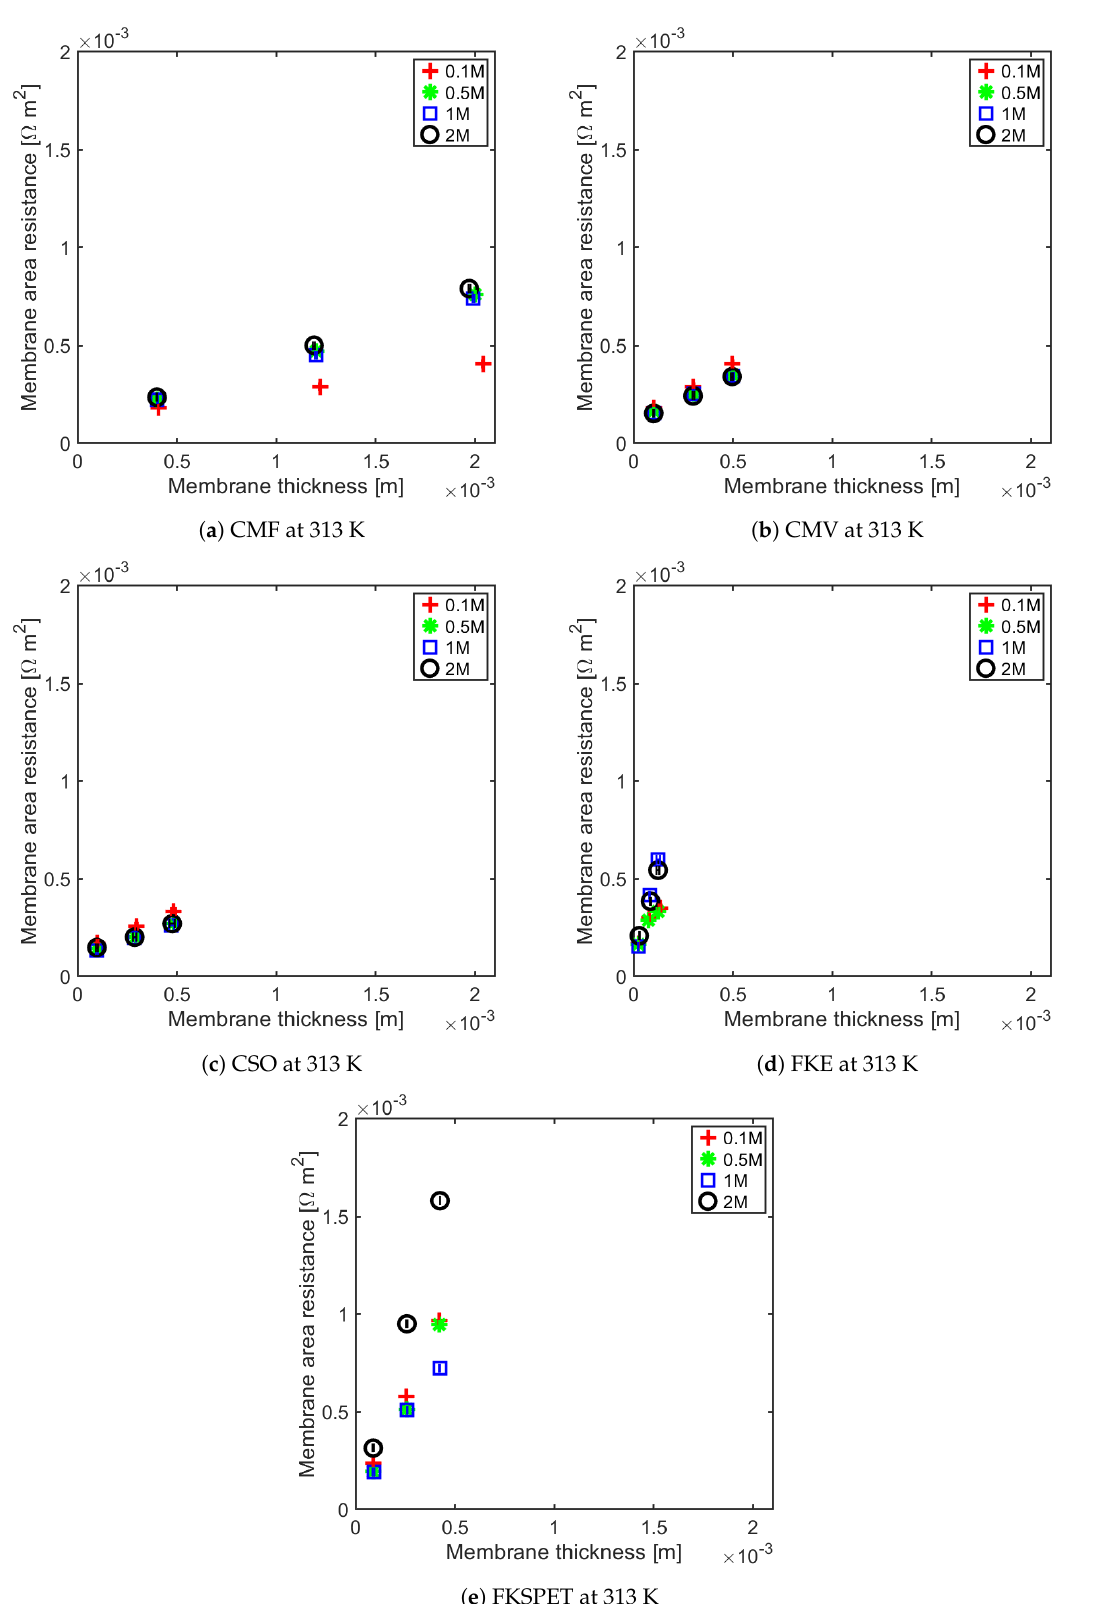
Figure 8. CEM resistance as a function of thickness for different concentrations at 313